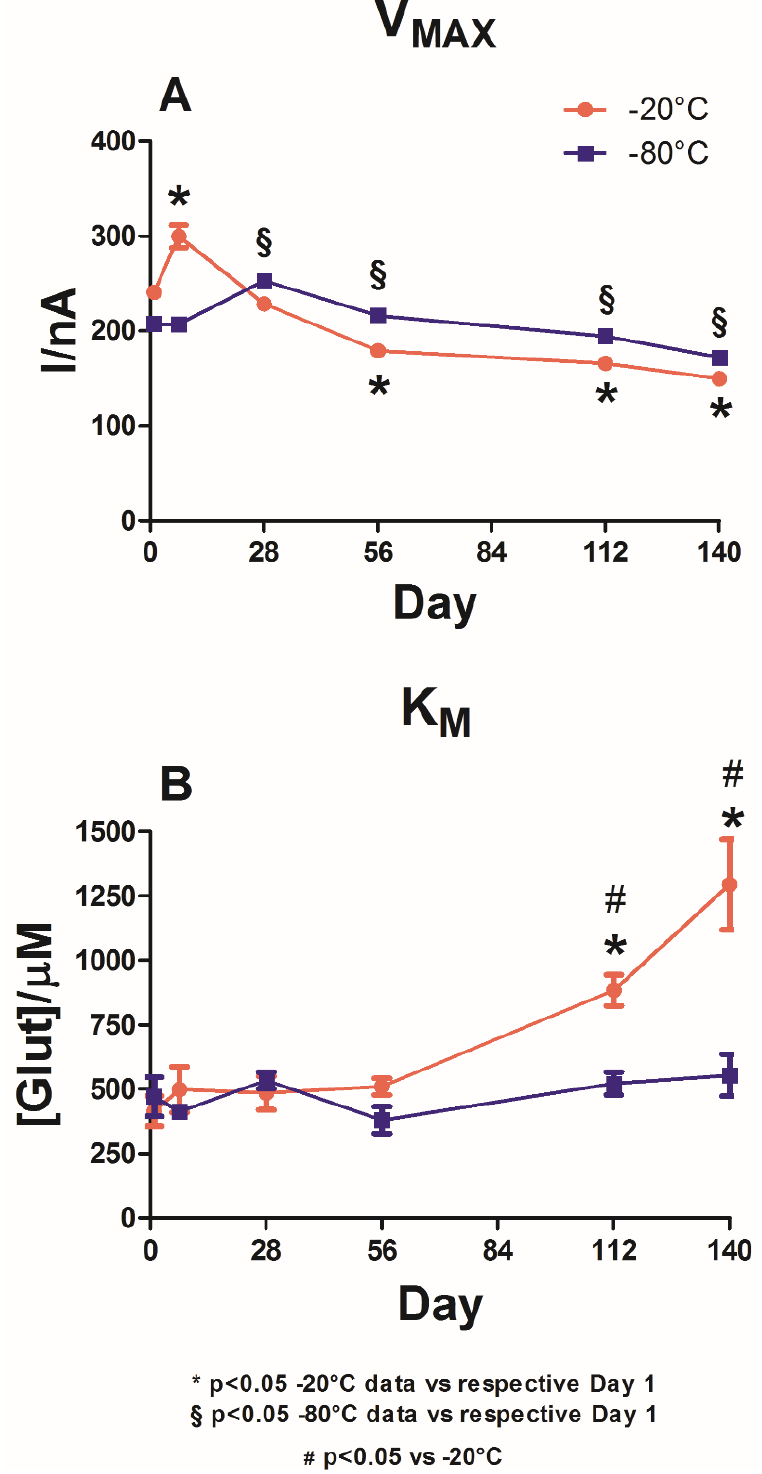
Figure 4. Graph describing the variations in V MAX (Panel ( A )) and K M (Panel ( B )) over a range of 140 days for the biosensor design Ptc/PPD/PEI(1%) 2 /GlutOx 5 /TEG(1%) when stored at −20 °C (red plot) and −80 °C (blue plot). The subscript number represents the number of deposition steps while the brackets report the concentrations of the component. Ptc: Pt cylinder 1 mm long, 125 µm in diameter; GluOx: L-glutamate oxidase; PPD: poly-ortho-phenylenediamine; PEI: polyethyleneimine; TEG: triethylene glycol.